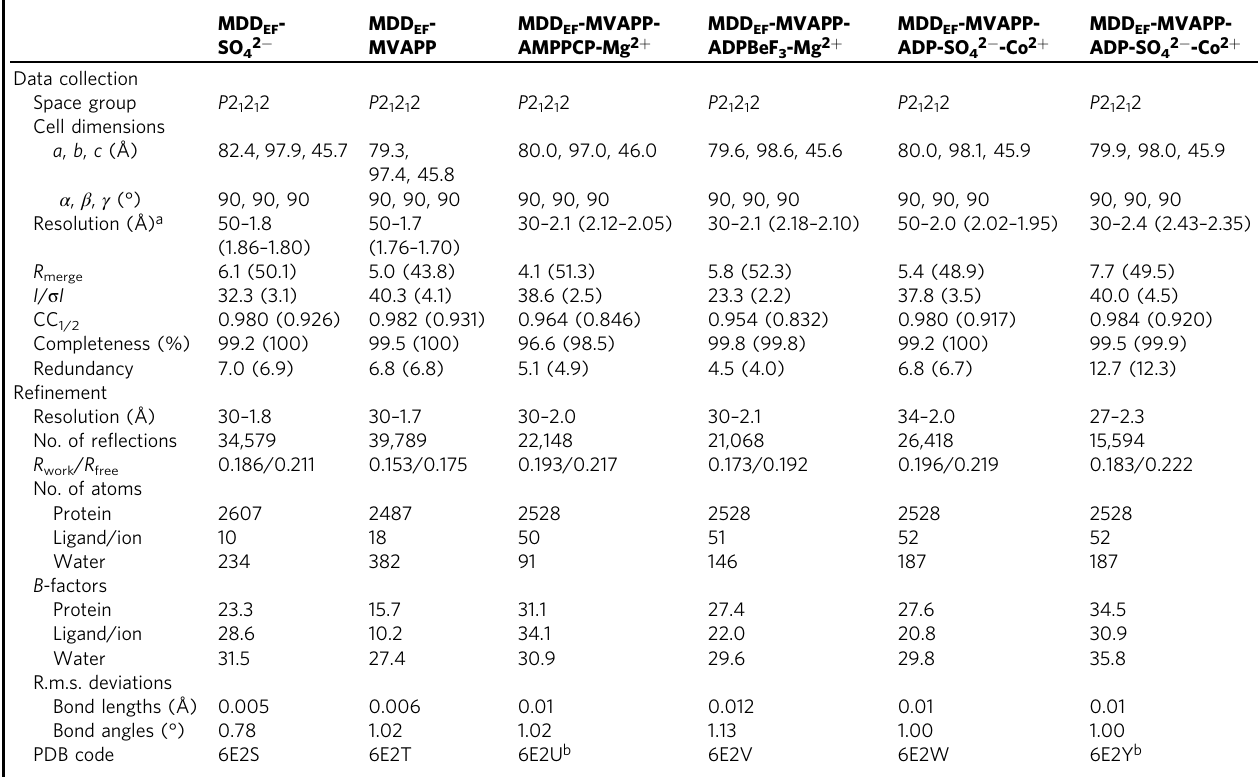
a Values in parentheses indicate the highest-resolution shell. b Data were collected on the home source with CuK α X-ray